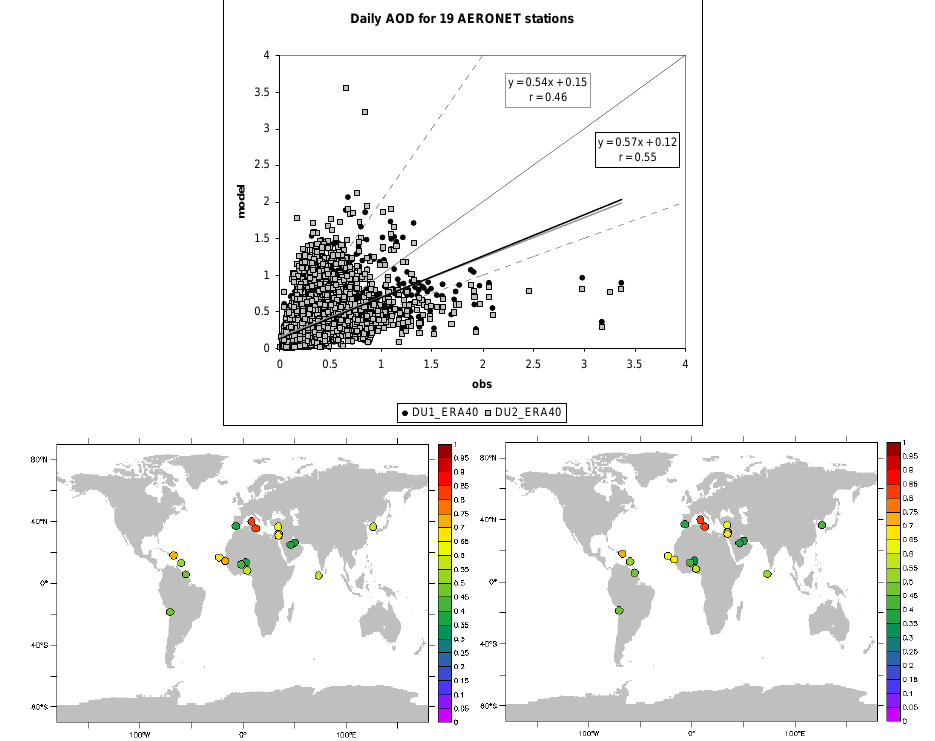
Fig. 11. Scatter plot of the modelled versus measured daily AOD550nm from the 19 AERONET stations for the DU1 ERA40 and the DU2 ERA40 simulations. The dotted lines correspond to 1 : 2 and 2 : 1 relationship. The two lower panels show the correlation coefficients for each of the 19 stations for the DU1 ERA40 (left) and DU2 ERA40 (right) simulations (daily